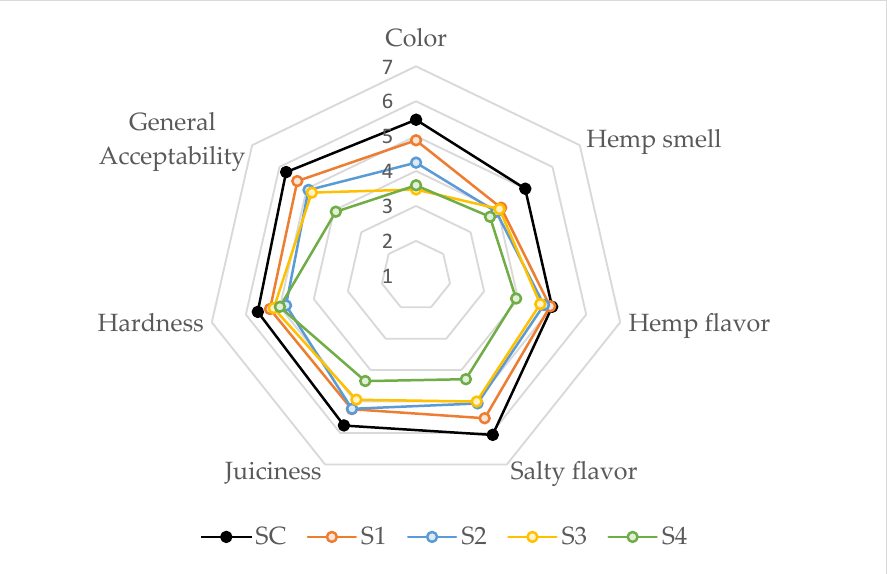
Figure 3. Effect of partial and total replacement of pork back fat by the gelled emulsion, from hemp oil and buckwheat flour, on sensory parameters. SC: frankfurter without GE; S1: frankfurter formulated with GE as 25% fat replacer; S2: frankfurter formulated with GE as 50% fat replacer; S3: frankfurter formulated with GE as 75% fat replacer, and S4: frankfurter formulated with GE as 100% fat replacer.